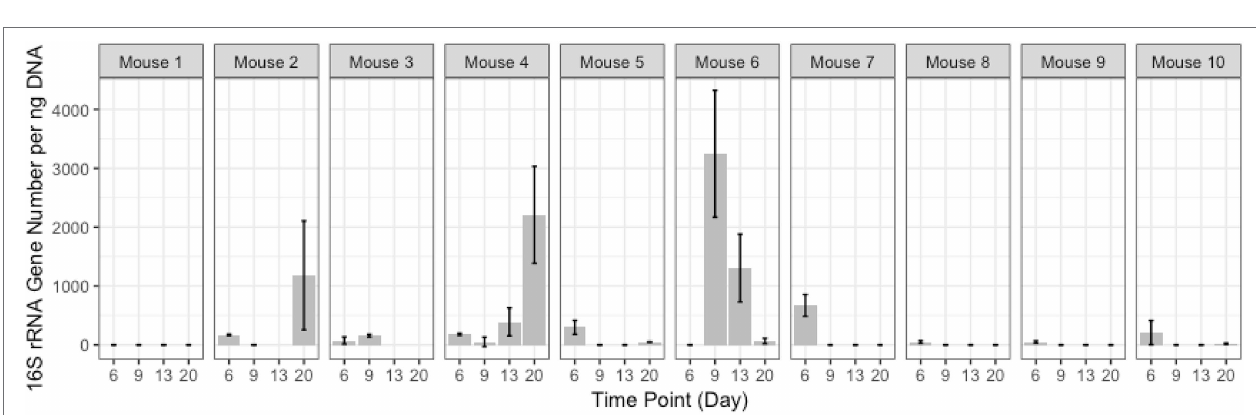
circles representing neutropenic mice ( Supplementary Figure 2 ).